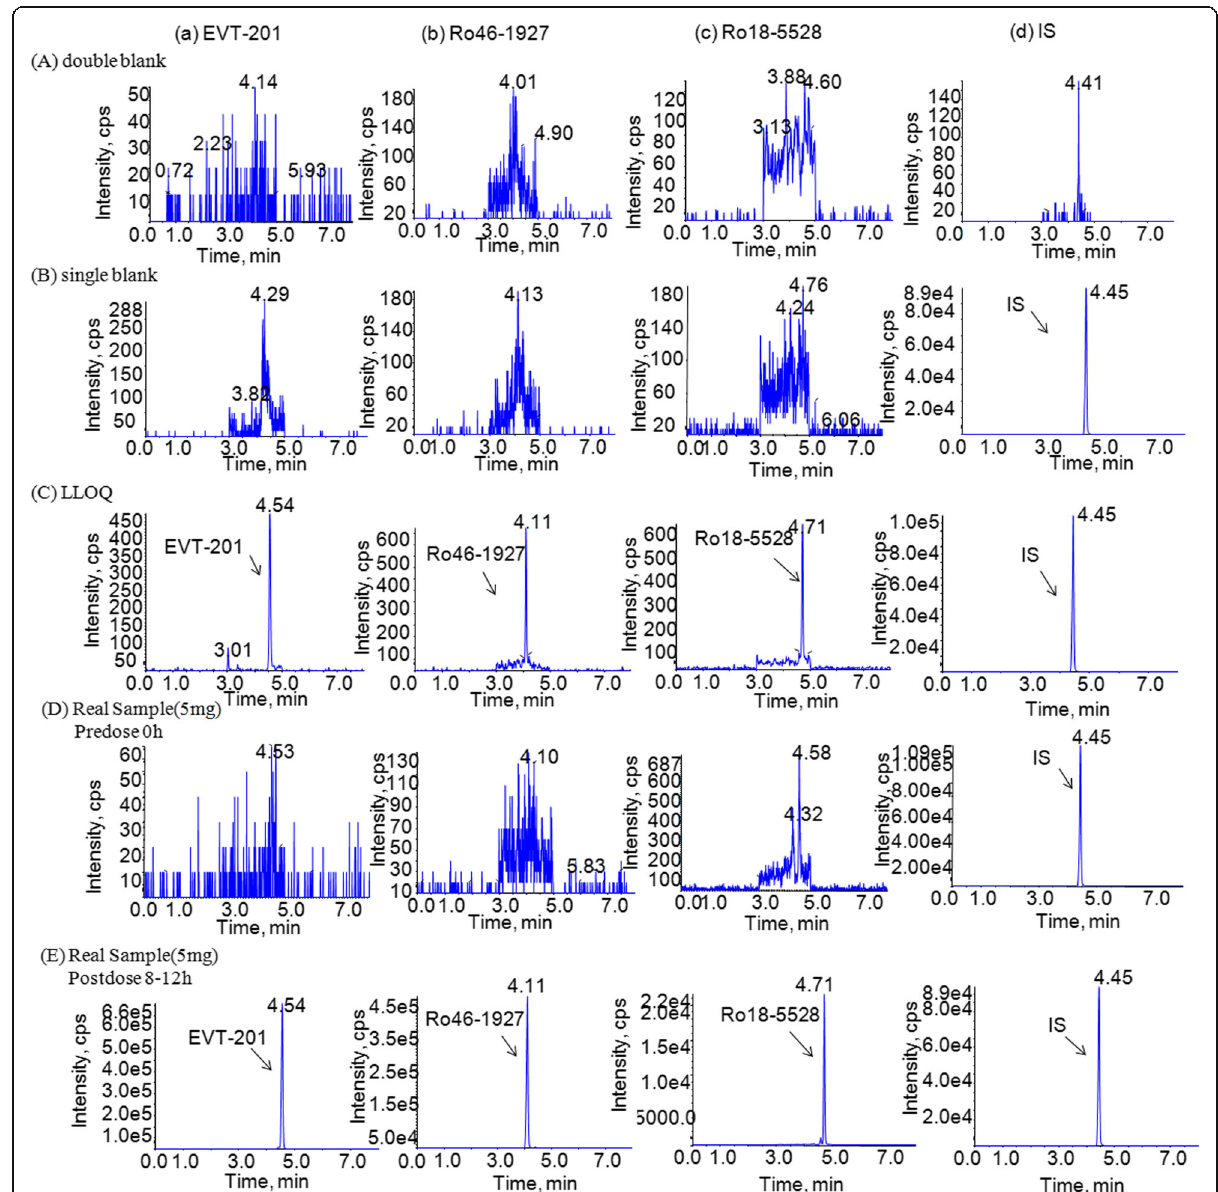
Fig. 2 Representative chromatograms of A double blank urine, B single blank urine (IS conc. 100ng/mL), C a spiked sample at LLOQ (analytes conc. 0.2ng/mL; IS conc. 100ng/mL), D a real sample predose, and E a real sample after oral administration of 5mg EVT201 capsule (8 – 12h